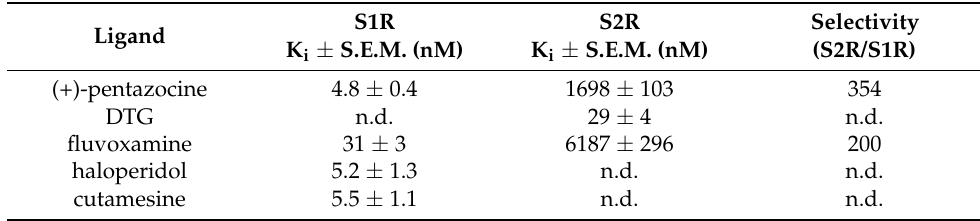
Table 2. Sigma-1 and sigma-2 receptor binding affinity (K i ) and S2R/S1R selectivity for known sigma receptor ligands